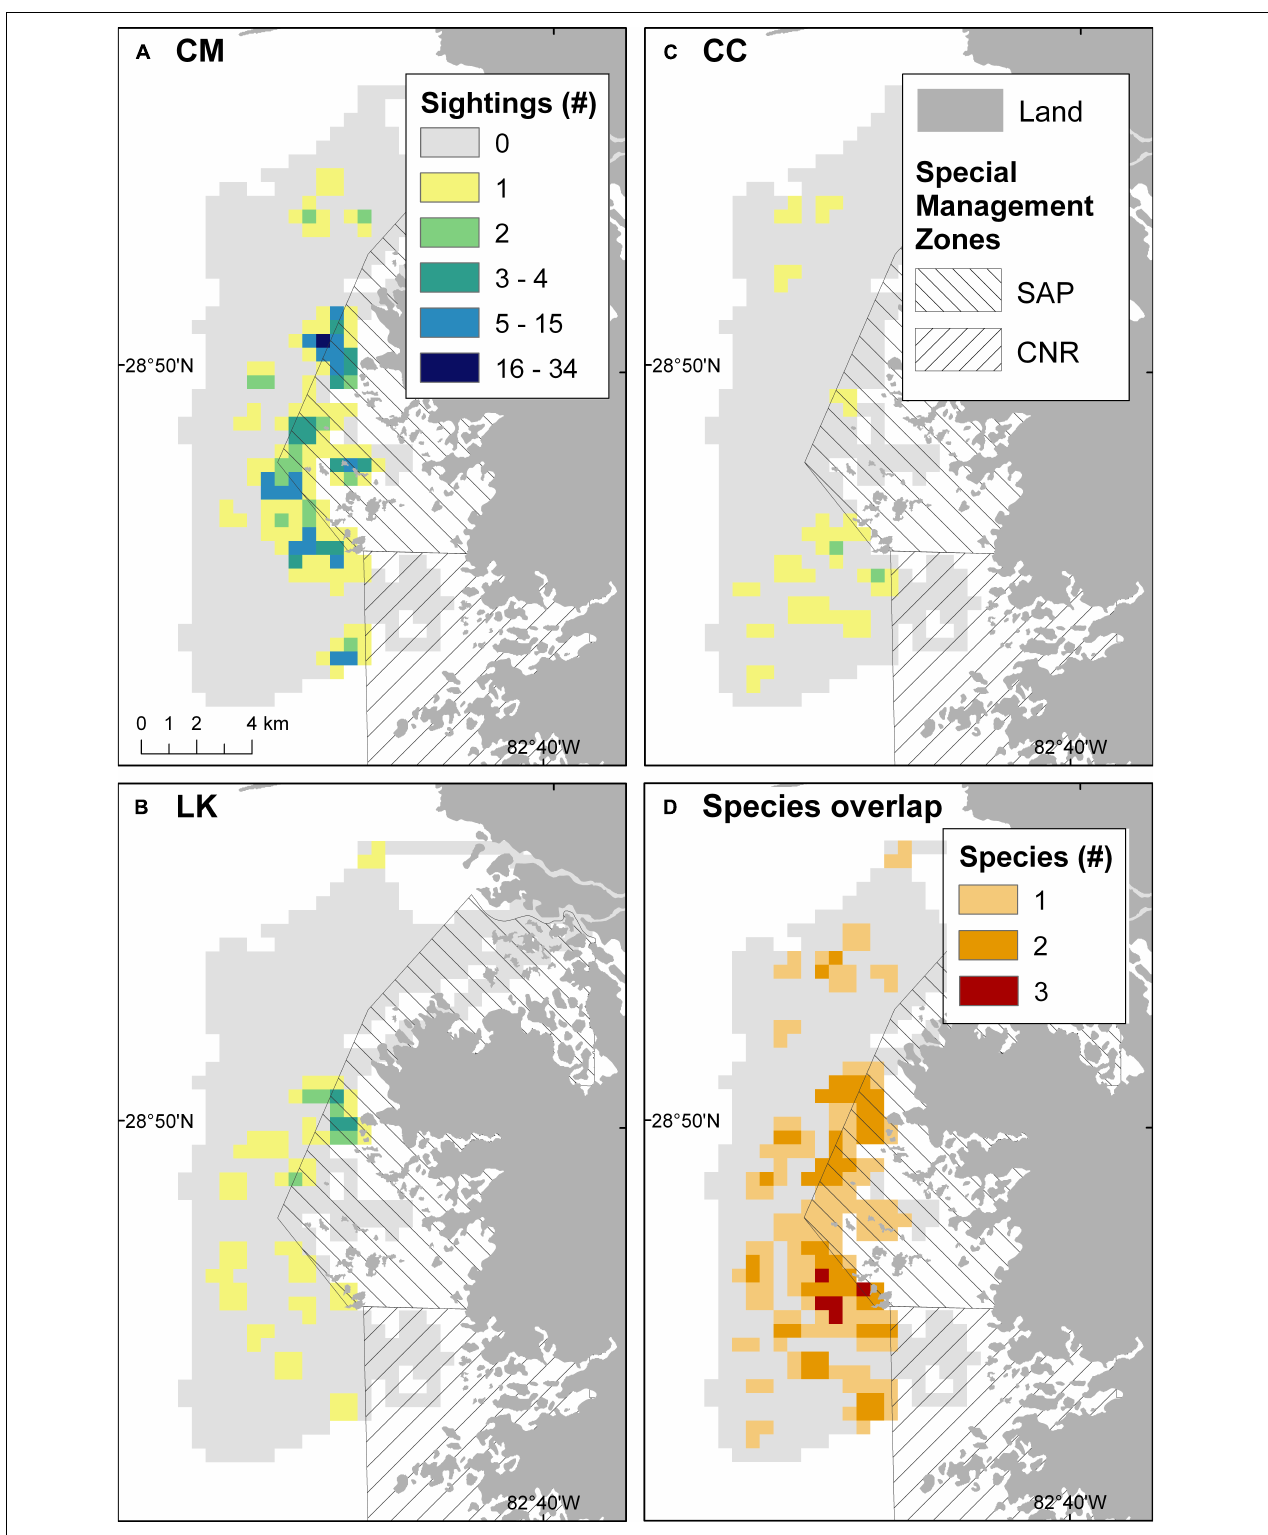
FIGURE 2 | Spatial distribution of marine turtle sightings between July and September 2016 in the Crystal River region, United States: (A) 245 CM green turtles; (B) 34 LK Kemp’s ridley turtles; (C) 18 CC loggerhead turtles; and (D) the overlap of species (number of marine turtle species recorded in each cell). Light gray cells represent surveyed areas where no marine turtles were sighted. SAP, St. Martins Marsh Aquatic Preserve; CNR, Chassahowitzka National Wildlife Refuge.